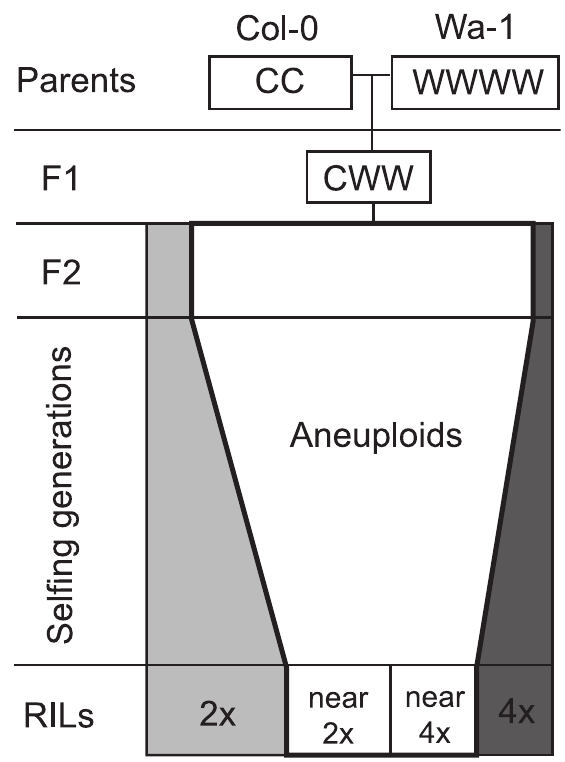
Figure 1. Diploid, Tetraploid, and Aneuploid Individuals in the Progeny of a Triploid The proportions of diploid (light gray), tetraploid (dark gray), and aneuploid (white) individuals represent those observed in the CWW F 2 population and the Col-0 3 Wa-1 RILs [24]. The progressive decline of aneuploidy towards euploidy during the selfing generations is extrapo- lated.